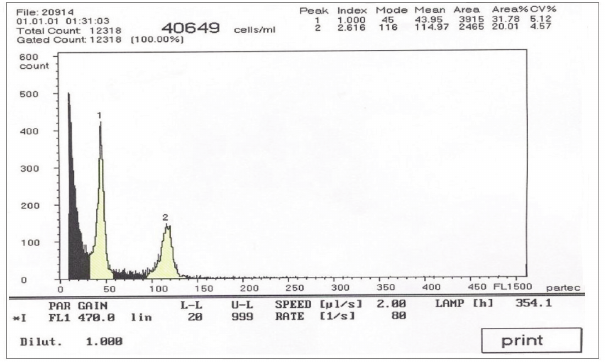
Fig. 2 - Flow cytometry analysis of C. roseus ‘Alba’ cell nuclei in diploid (peak 1) and index plant of parsley in diploid sta- tus (peak 2).